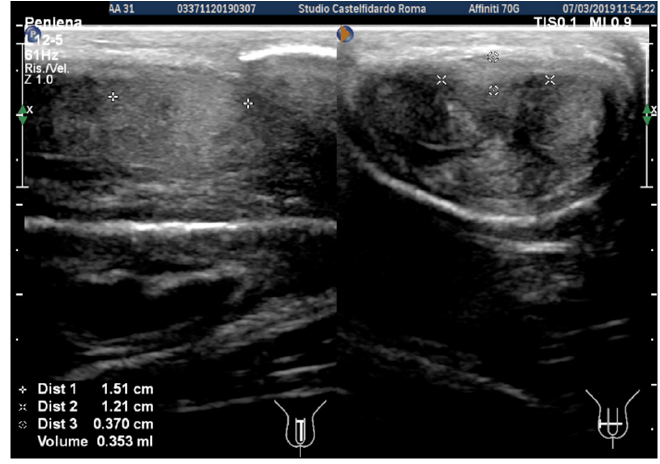
Figure 2. Ultrasonography of the penis before treatment (longitudinal and transverse views). Table 1. Case summaries of three patients with Peyronie’s disease treated with combined multi ‐ modal therapy.